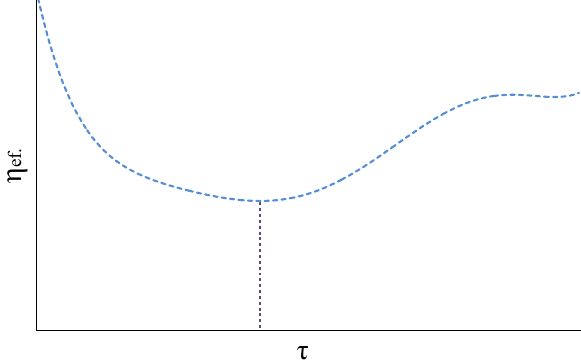
Figure 1 Rheogram for CMC solution